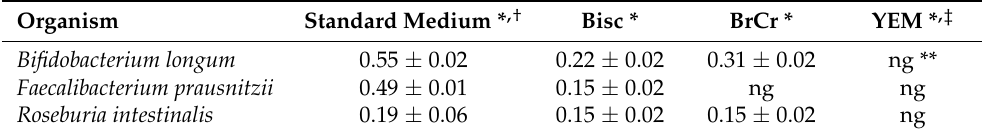
Table 1. Steady state culture densities of select bacterial species grown anaerobically in batch culture. Organism Standard Medium * , † Bisc * BrCr * YEM * , ‡ Bifidobacterium longum 0.55 ±